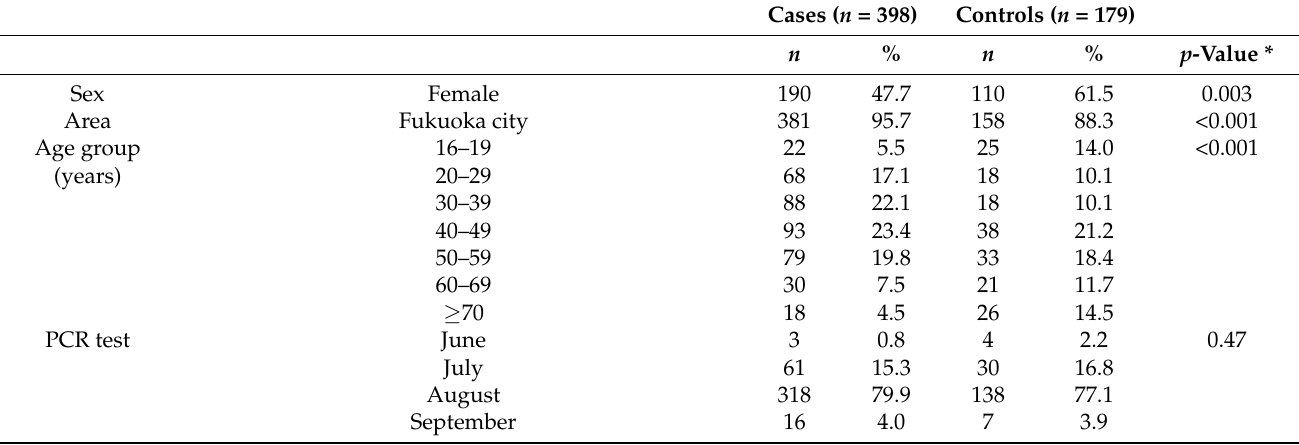
Table 1. Characteristics of the study